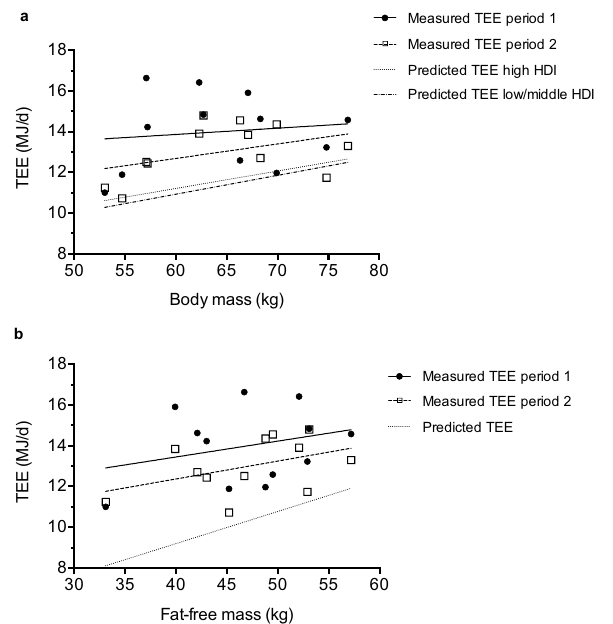
Figure 4. Measured total energy expenditure (TEE) and TEE predicted by body mass ( a ) and fat-free mass ( b ). Predicted TEE high or low/middle HDI refers to the prediction equation created with countries rated as either high, or low/middle on the human development index